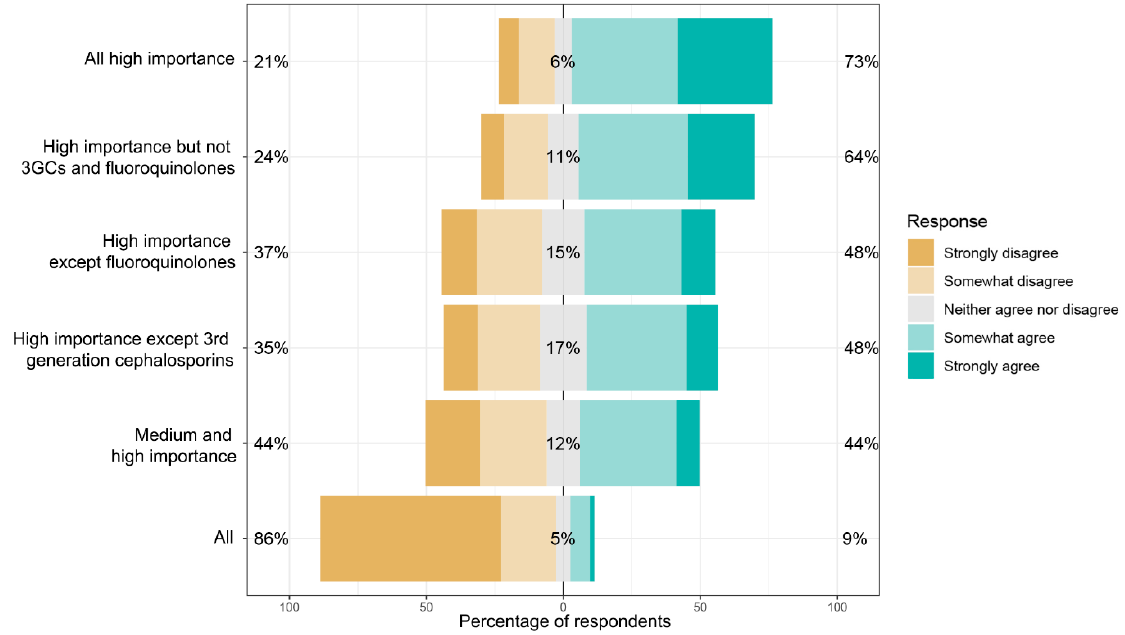
Figure 1. Responses of all participants to the question: “If there were to be restrictions placed on veterinary prescribing of antimicrobials, to which antimicrobials should they apply?”. veterinary prescribing of antimicrobials, to which antimicrobials should they